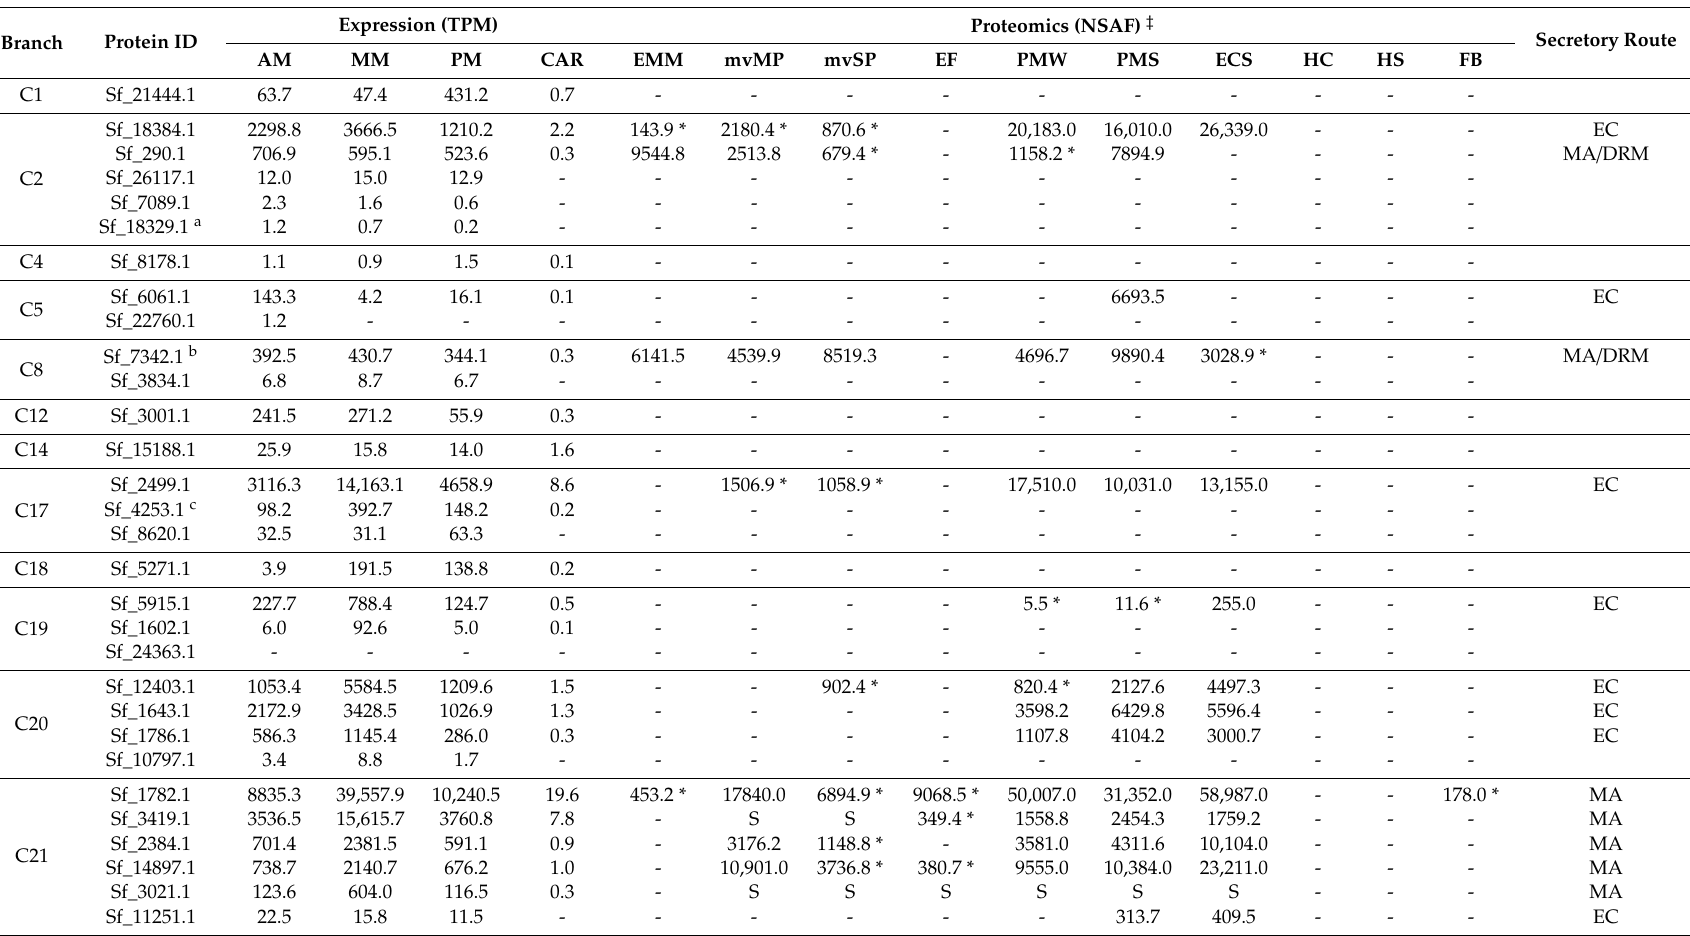
Table 2. Spodoptera frugiperda chymotrypsin gene expression and proteomic analysis